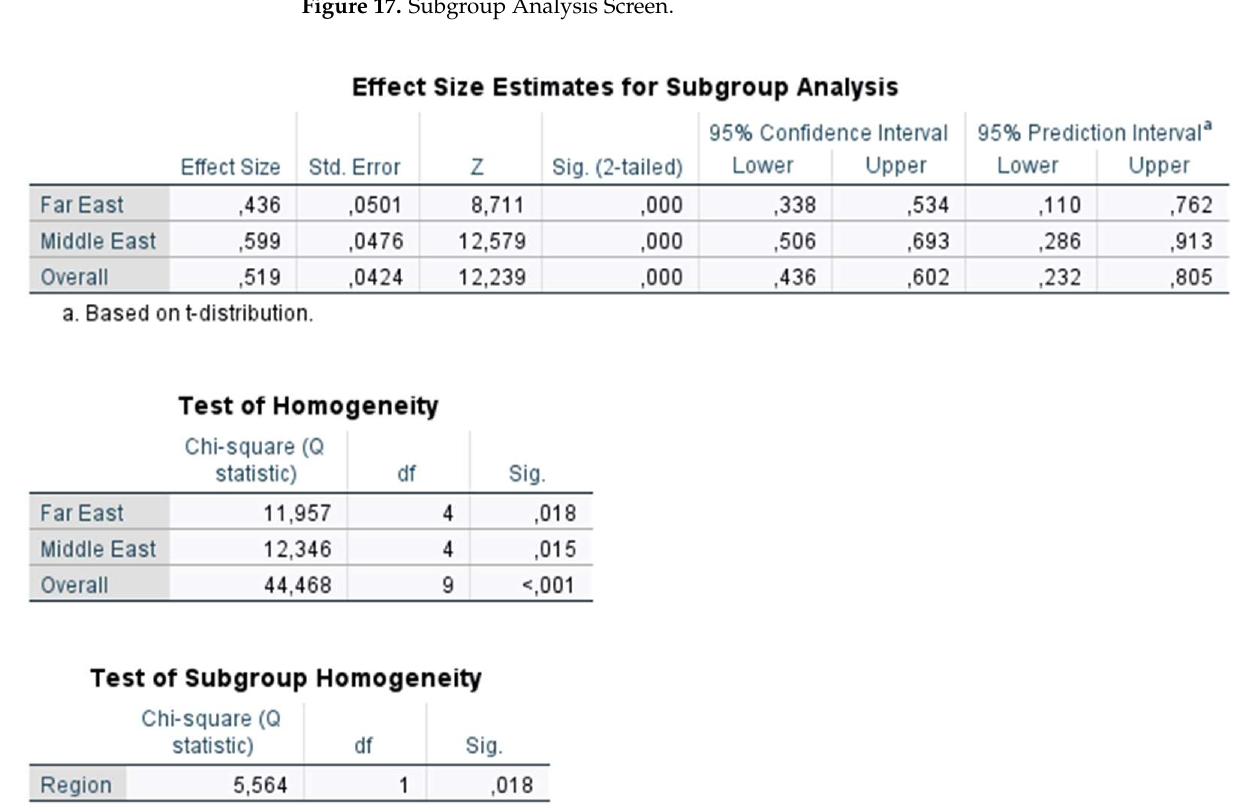
Figure 18. Results of Subgroup Analysis with Region